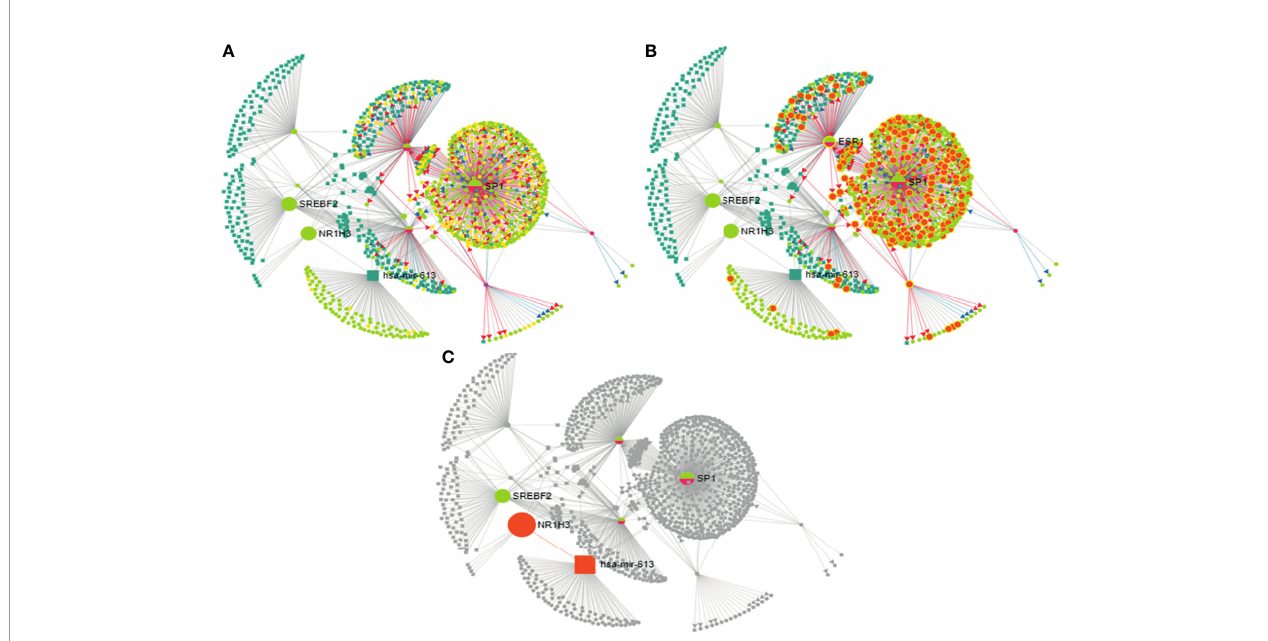
FIGURE 8 | Analysis of mir-613 network using miRNA-centric network visual analytics platform: (A) Represents the network connecting hsa-mir-613 with the important transcription factors, miRNAs with the main node being NR1H3 (LXR a ), SREBPF2, SP1, and ESR1 (ER a ). (B) Enriched with function biological process: cell proliferation. (C) Represents the pathway connecting liver X receptor (LXR) and ESR1 (ER a ) to